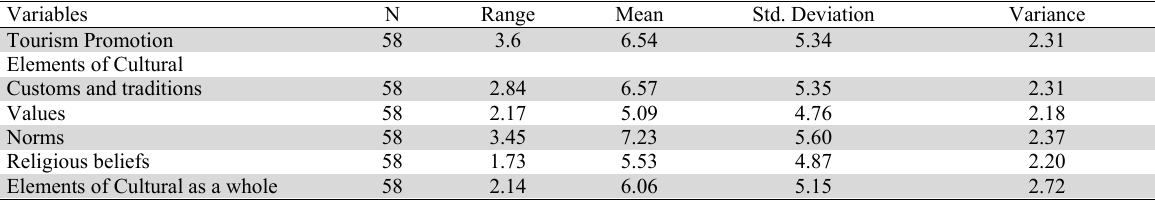
The summary of statistical observations